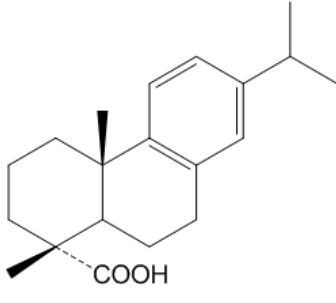
Figure 1. Structure of dehydroabietic acid (DAA).